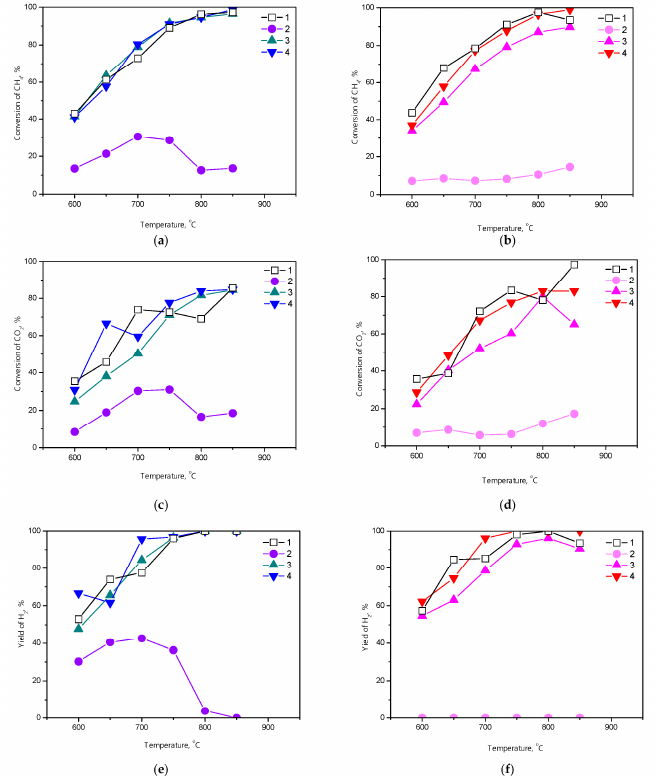
Figure 7. Performance of the Ce 1−x Ni x O 2−x /Al 2 O 3 catalysts in biogas conversion to hydrogen. ( a , c , e ) 10Ni/Al 2 O 3 -CI (1), 5Ce 0.2 Ni 0.8 O 1.2 /Al 2 O 3 -CI (2), 10Ce 0.2 Ni 0.8 O 1.2 /Al 2 O 3 -CI (3), and 20Ce 0.2 Ni 0.8 O 1.2 /Al 2 O 3 -CI (4). ( b , d , f ) 10Ni/Al 2 O 3 -SG (1), 20Ce 0.8 Ni 0.2 O 1.8 /Al 2 O 3 -SG (2), 20Ce 0.5 Ni 0.5 O 1.5 /Al 2 O 3 -SG (3), and 20Ce 0.2 Ni 0.8 O 1.2 /Al 2 O 3 -SG (4). Each experimental point is the arithmetic mean found from the results of five measurements with a standard deviation of ±